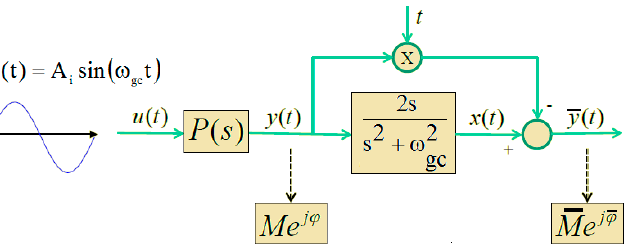
Figure 10. Experimental scheme used to compute the phase slope of the process at the gain crossover frequency (refer to [34] for details).